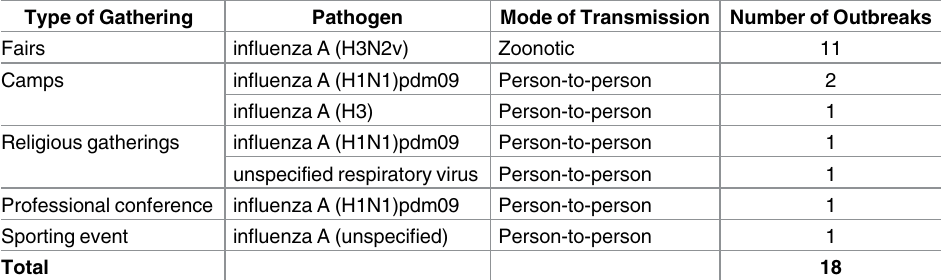
Table 3. Mass gathering-related respiratorydisease outbreaks by type of gathering, pathogen, and mode of transmission, United States, 2009–2014. Reportedby eight state health departments through an onlineassessment, March